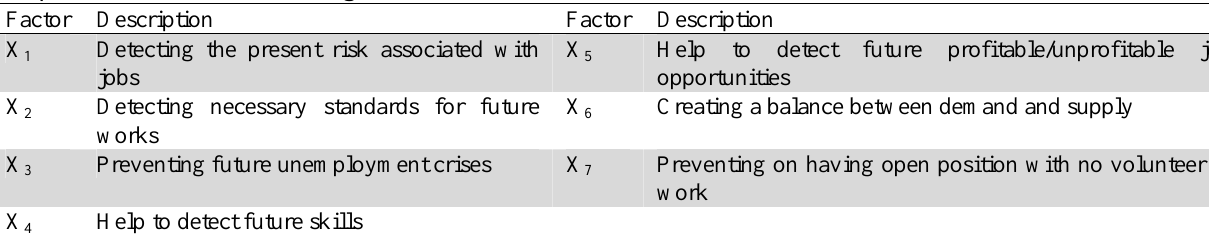
Important factors influencing future